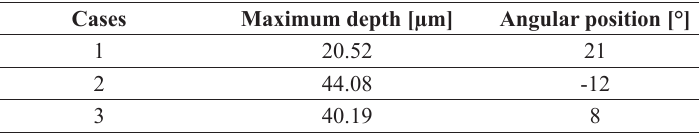
Manufactured bearings wear